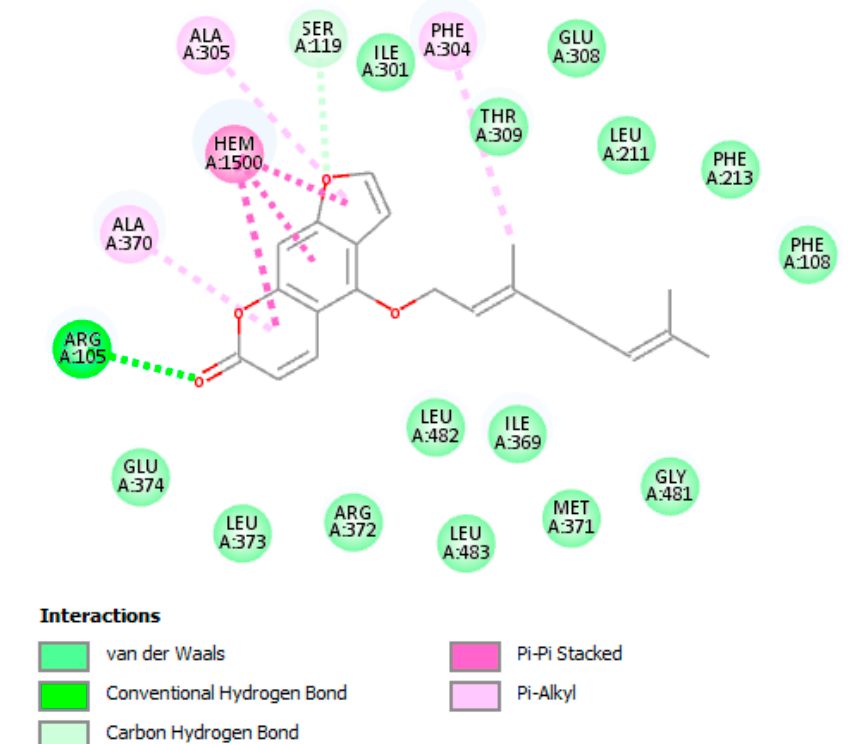
Figure 5. Berg (pose 6) 2D interactions, showing π – π display with the heme. There are also relevant interactions with Ser − 119 and Arg − 105. However, the large majority of residual action is of van der Waals type, and due to the hydrocarbon tail of bergamottin.